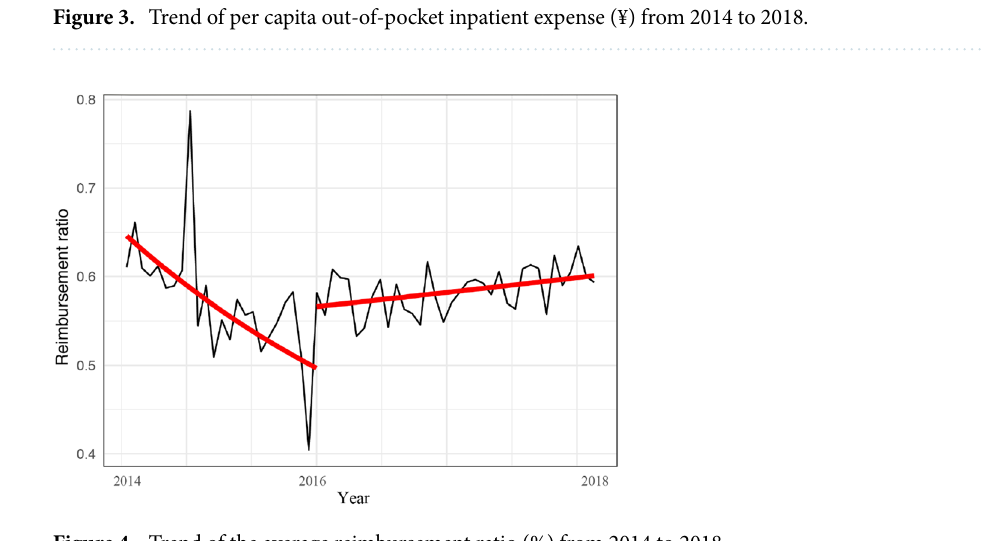
Figure 4. Trend of the average reimbursement ratio (%) from 2014 to